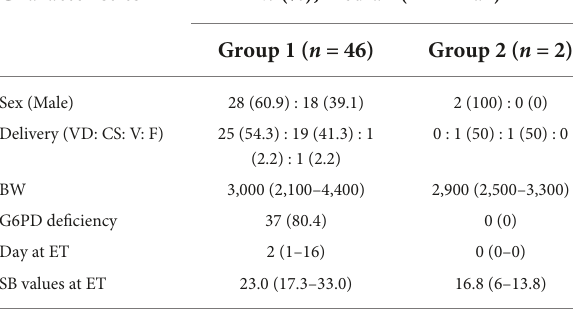
TABLE 2 Patient characteristics and causes of hyperbilirubinemia in neonatal cases requiring ET in Groups 1 and 2.